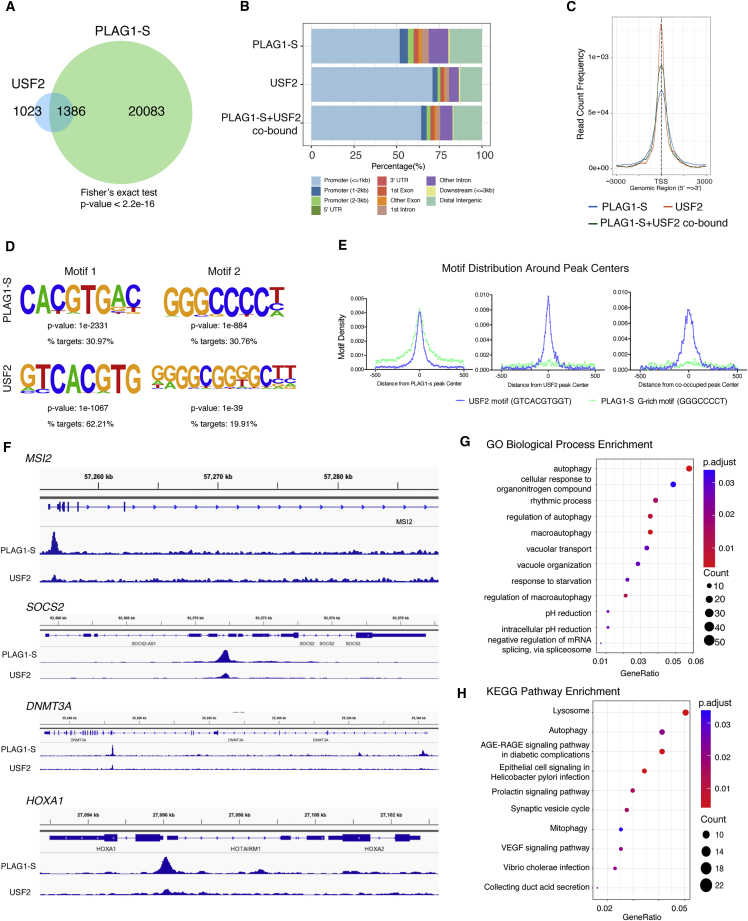
ChIP-Seq Mapping of USF2 and PLAG1-S Binding Identifies Co-occupancy at Promoters of MSI2 and Other HSC Regulators(A) Venn diagram showing the overlap of USF2 and PLAG1-S ChIP peaks within a 100 bp distance.(B) Peak distribution profiles of all PLAG1-S and USF2 peaks, along with the co-occupied sites (PLAG1-S + USF2).(C) Read distribution profiles of peaks found within ±3 kb of the TSS.(D) De novo motif discovery analysis of the PLAG1-S and USF2 peaks. Top two most significantly enriched motifs identified by HOMER are shown for each factor.(E) Motif density distribution profiles around peak centers for the USF2 consensus and the G-rich motif identified as the PLAG1-S consensus (motif 2) during de novo motif discovery.(F) Integrative genome browser tracks showing the ChIP signal at regulatory regions of MSI2, SOCS2, DNMT3A, and HOXA1.(G and H) Enrichment plots showing the biological process (G) and KEGG (H) pathways enriched in PLAG1-S + USF2 co-occupied sites using ChIPseeker R package. Counts represent the number of genes identified in each cluster and p.adjust are the adjusted p values using BH (Benjamini-Hochberg) method. GO, Gene Ontology.See also Figure S2 and Tables S4, S5, S6, and S7.